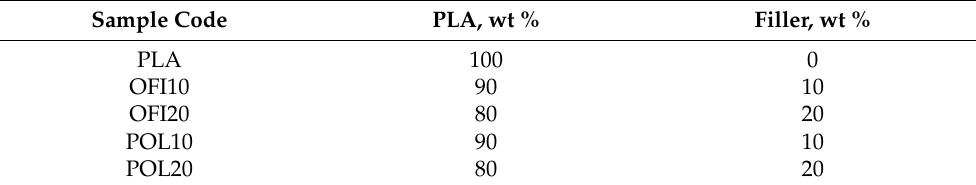
Table 2. 3D printed samples and related codes.